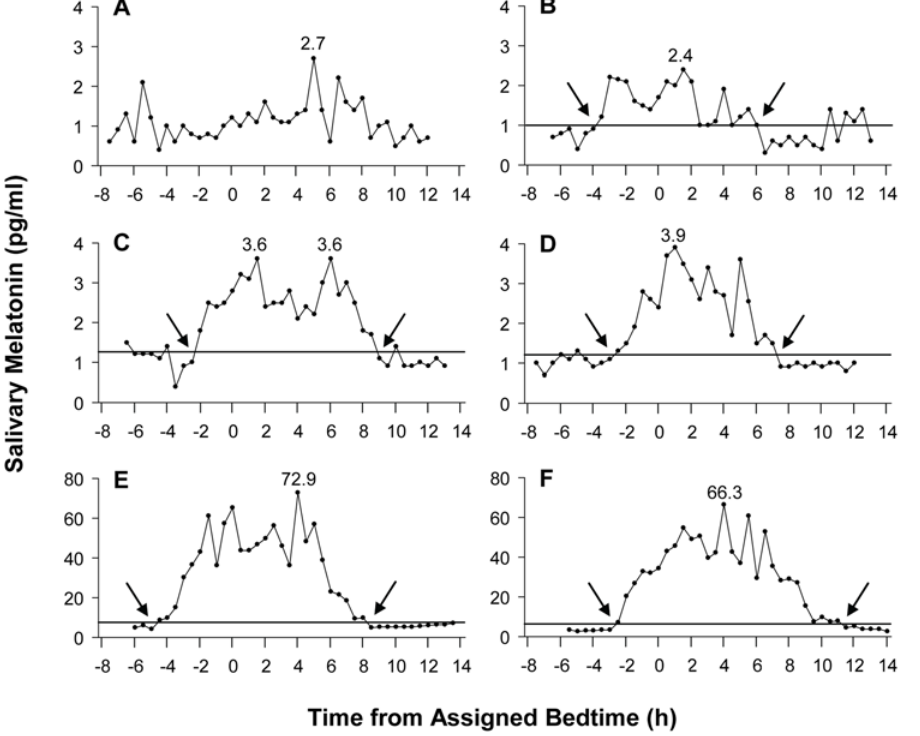
Figure 1. Six individual melatonin profiles determined from half hourly saliva samples collected in dim light. Shown are two melatonin profiles with the lowest AUC (A, B), two melatonin profiles with low AUC but normally shaped melatonin profiles (C, D), and two melatonin profiles with the highest AUC (E, F). The profiles are plotted with reference to assigned bedtime. The peak value of each profile is shown above the corresponding point on the profile. The threshold used to determine the DLMO and DLMOff is represented by the horizontal line. The DLMO and DLMOff are indicated by arrows.